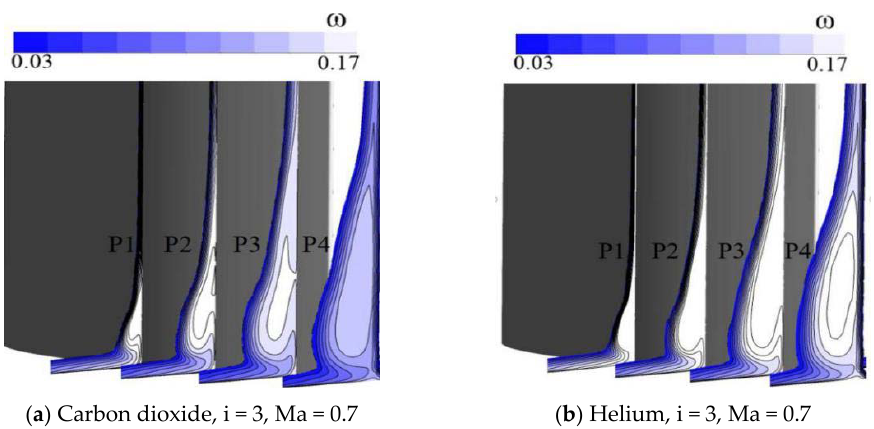
Figure 9. Contour of coefficient of total pressure loss at different plane.